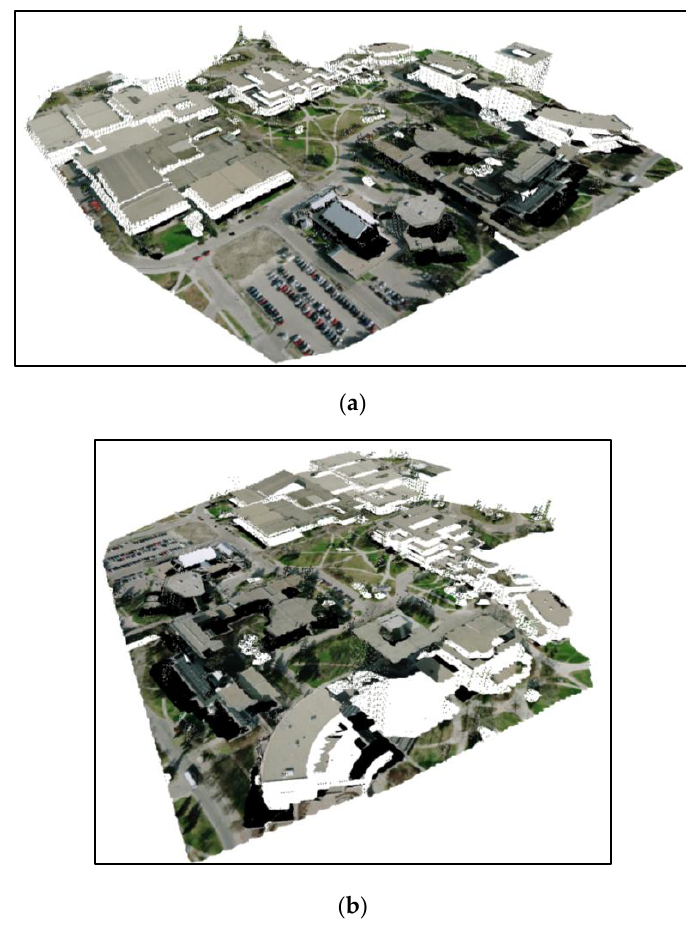
Figure 30. Realistic 3D surface reconstruction outcome for the first dataset: ( a ) and ( b ) two different views from the textured planar surfaces and individually colored non-segmented points.